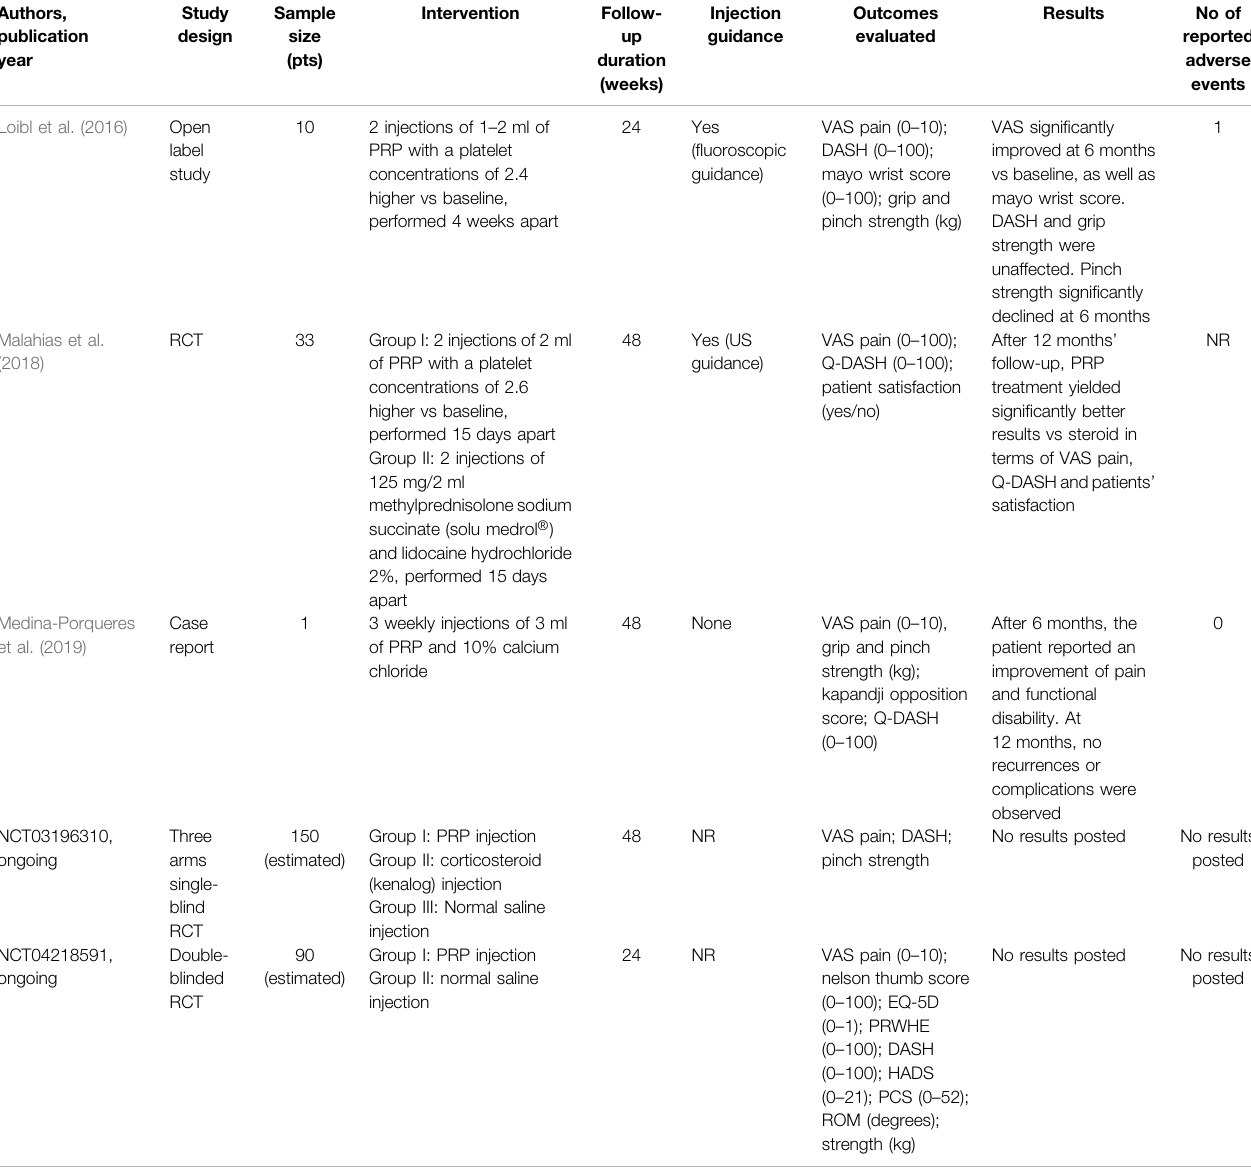
TABLE 3 | Summary of studies investigating intra-articular injections of platelet-rich plasma for the treatment of thumb-base